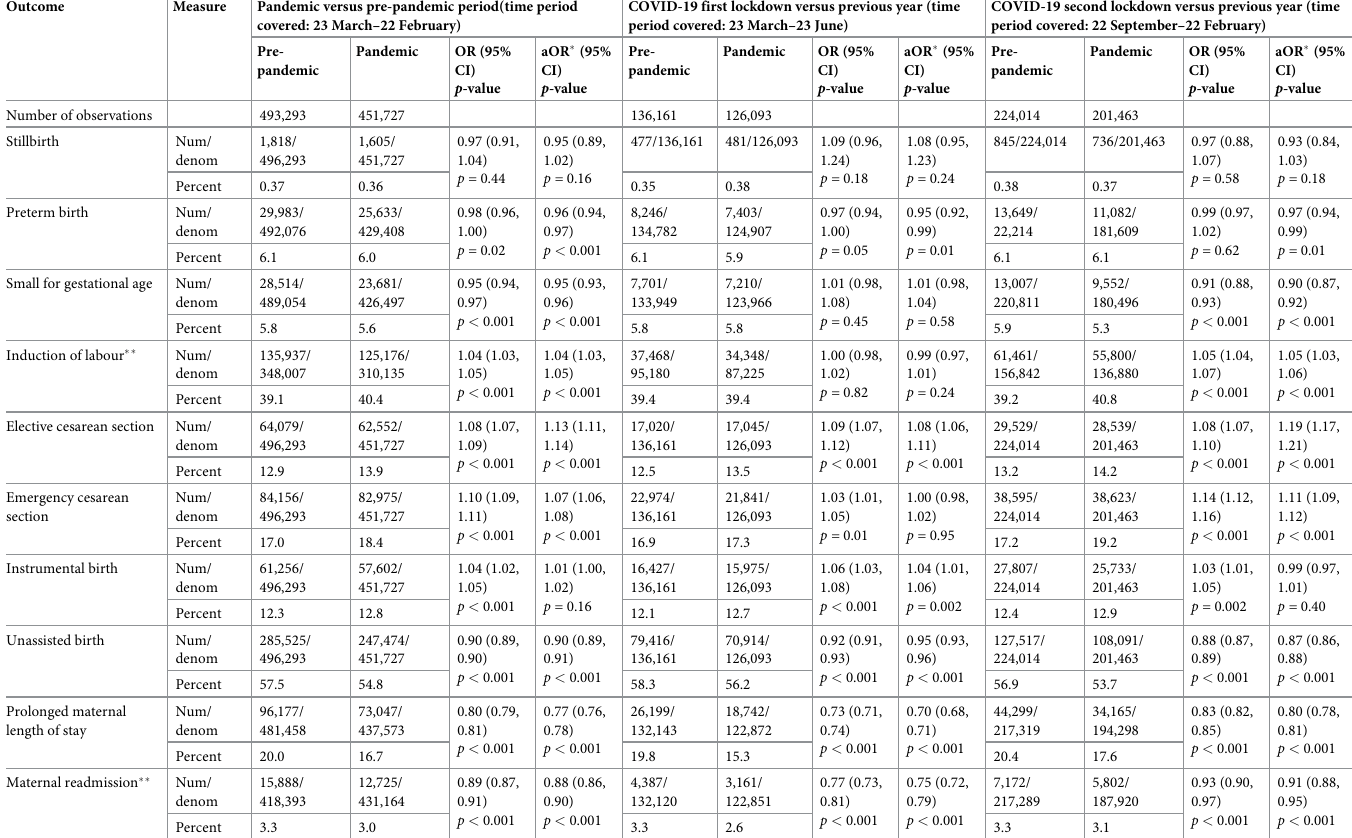
Table 2. Comparisons of outcomes in the COVID-19 pandemic and lockdown periods with the same periods in the previous year. Outcome